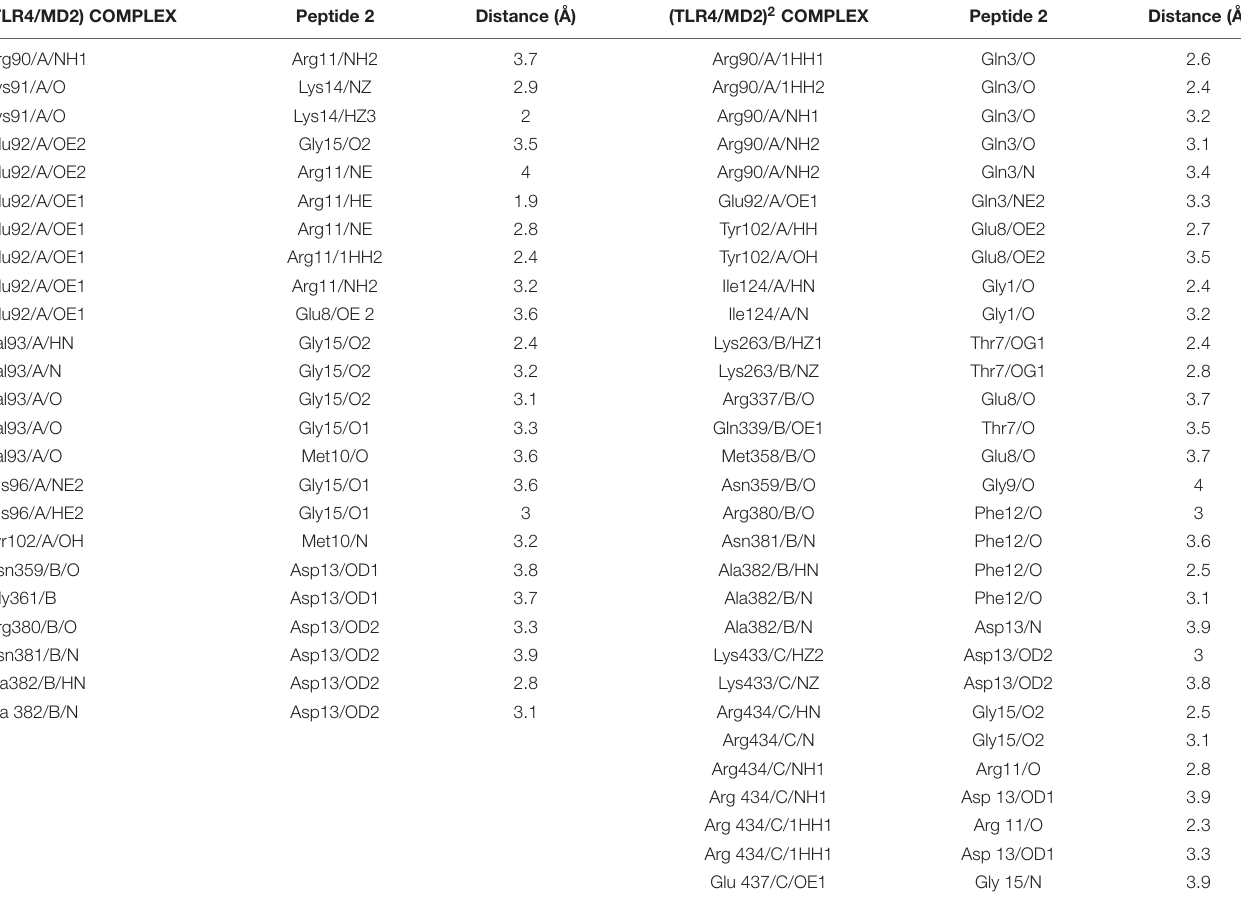
TABLE 2 | Interacting residues and distance of the best obtained docking peptide conformation with Autodock Vina 1.1.2. (TLR4/MD2) COMPLEX Peptide 2 Distance (Å) (TLR4/MD2) 2 COMPLEX Peptide